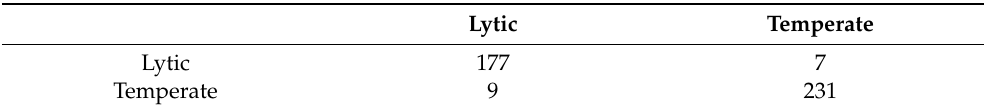
Table 3. Confusion matrix of the prediction of phage lifestyle by using integrase, Cro/CI, immunity repressor, ParA, and antirepressor